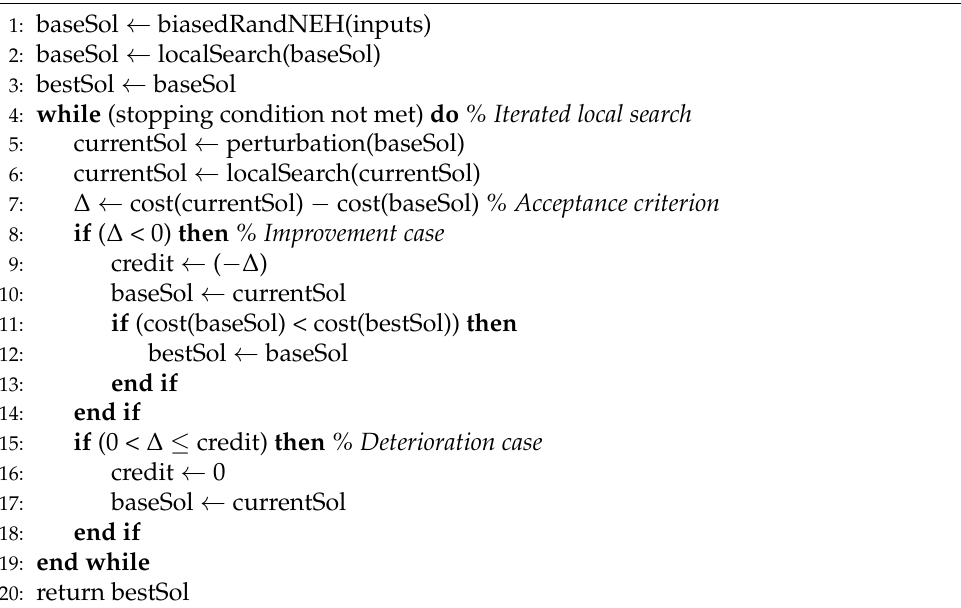
Algorithm 1 BR-ILS metaheuristic for the deterministic PFSP